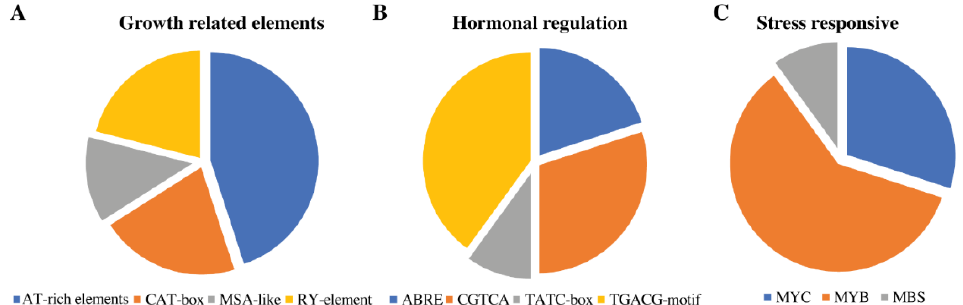
Figure 7. Cis -regulatory elements in the 2 kb upstream region of each RcbHLH gene member. The cis -elements associated with different physiological processes are represented ( A – C).